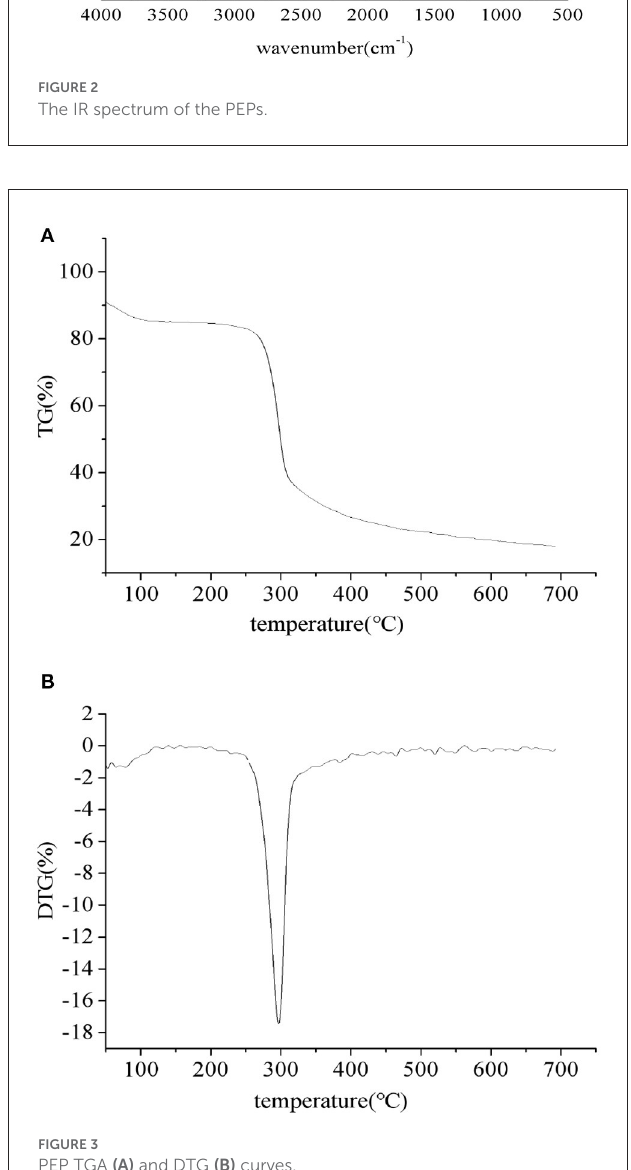
FIGURE3 PEP TGA (A) and DTG (B)